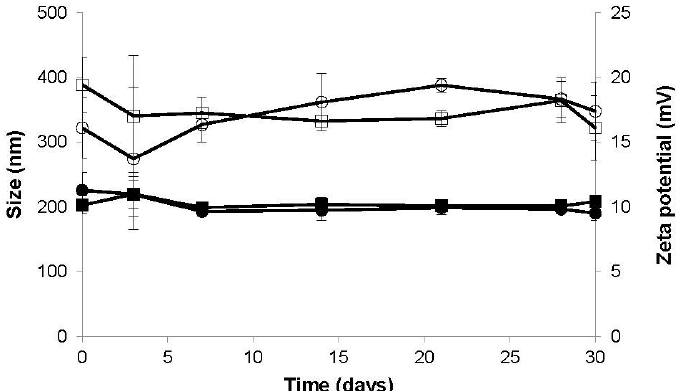
Figure 3. Evolution of the size (dark symbols) and zeta potential (empty symbols) of CS/CHS = 3/1 (circles) and CS/CHS = 4/1 (squares) nanoparticles as a function of time,